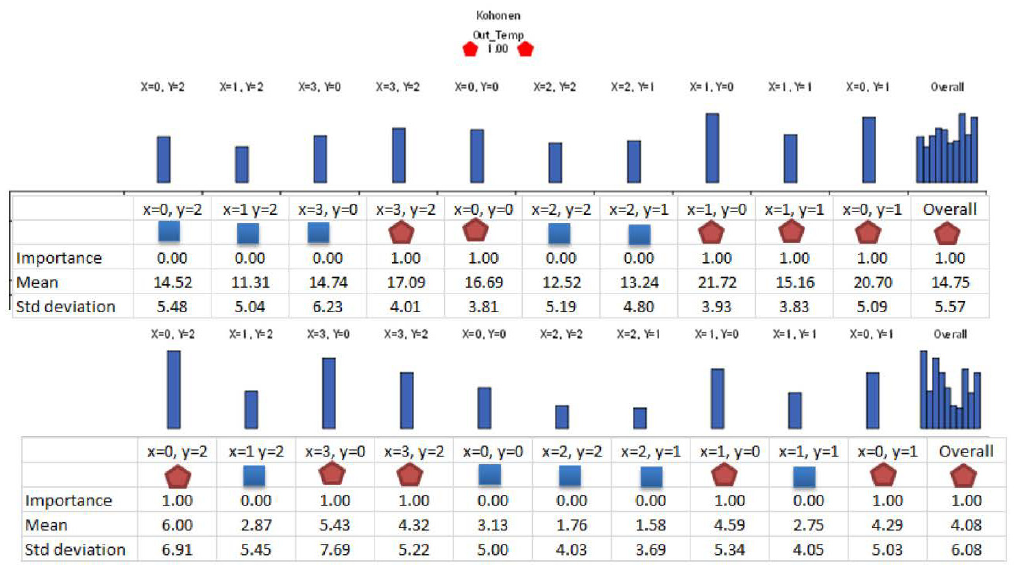
Figure 8. Self-organising map (SOM) cluster profiles showing the input variables at different levels of “importance” in the clustering of the respective individual variable even though all the variables are shown as important in the overall SOM clustering (right side of the